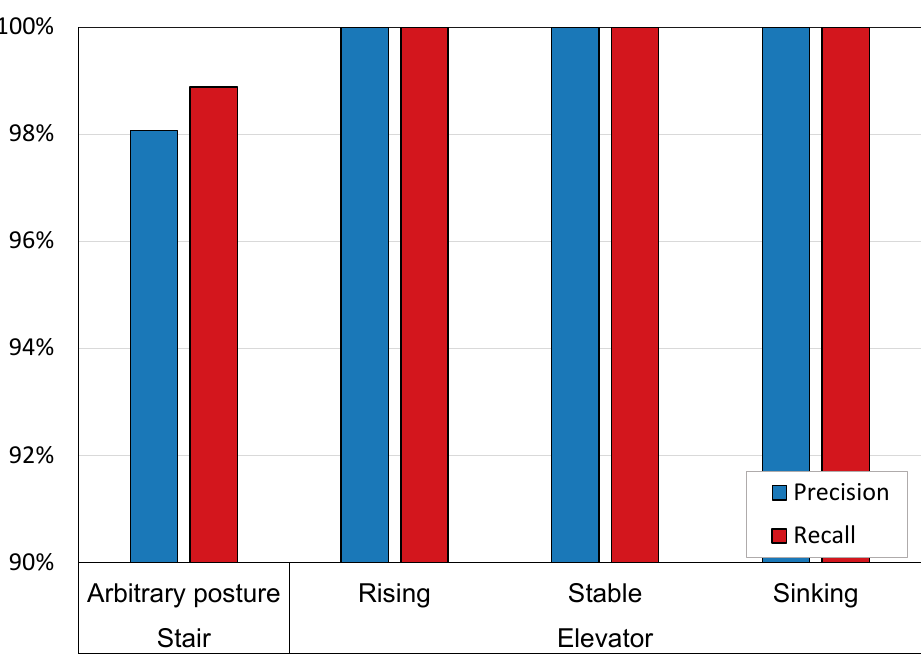
Figure 17. Recall and precision of stair and elevator